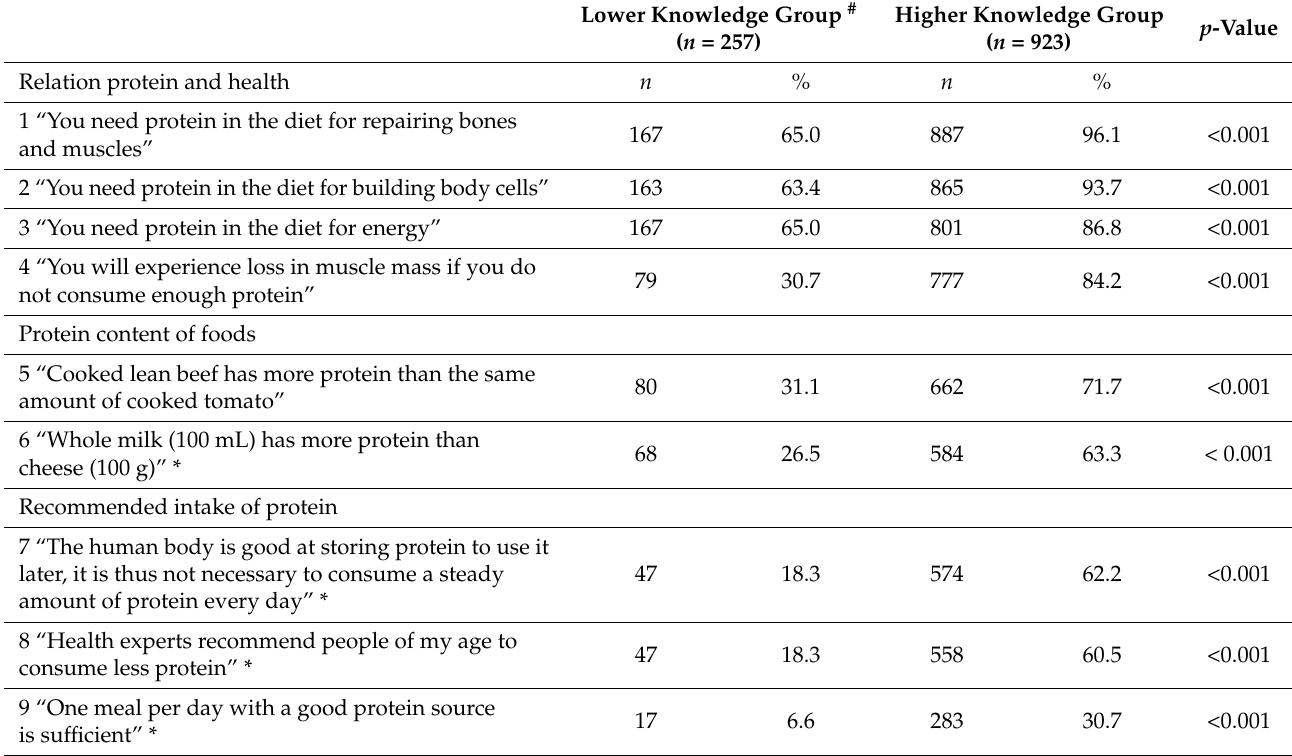
Table 2. Number ( n ) and percentage of participants (%) with a correct answer for each of the nine protein knowledge statements by the two knowledge level groups ( n = 1180).